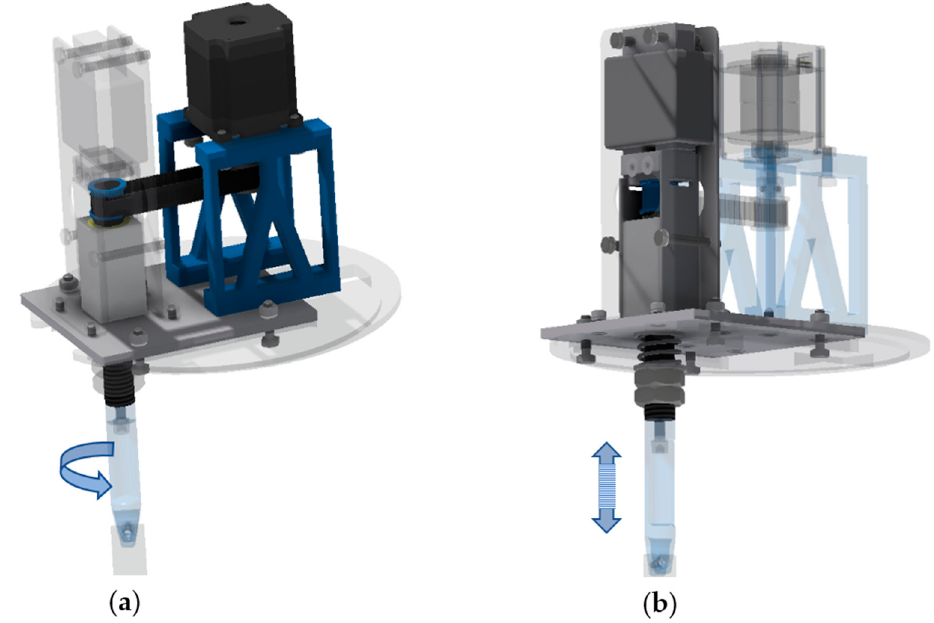
Figure 4. Two main kinematic units of the active holder: rotary ( a ) and vibration ( b ) motion of the active holder.